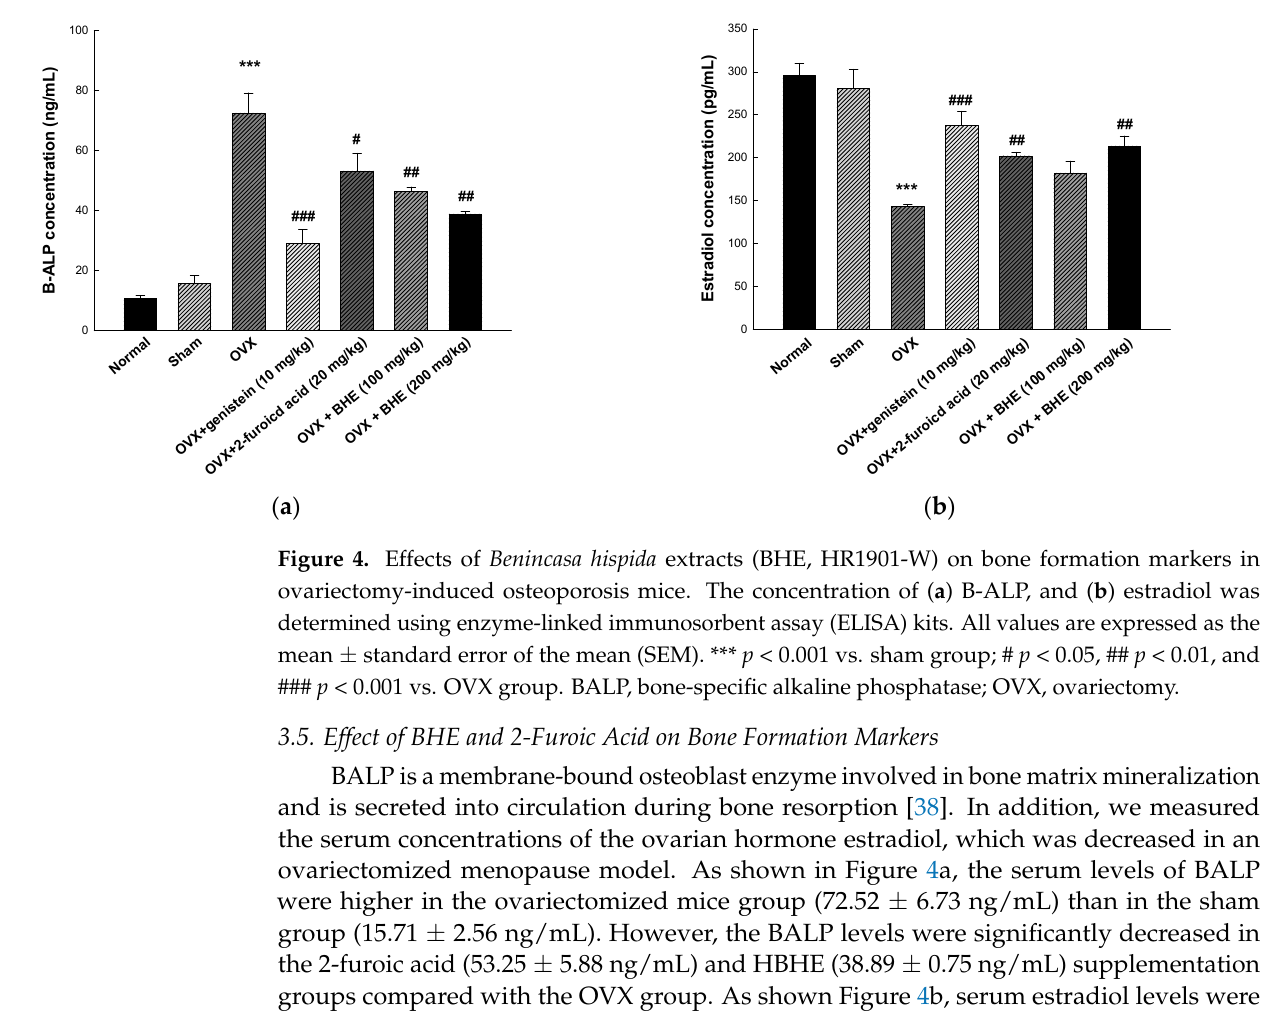
7 of 11 Figure 3. Effects of Benincasa hispida extracts (BHE, HR1901-W) on bone resorption markers in ovar-